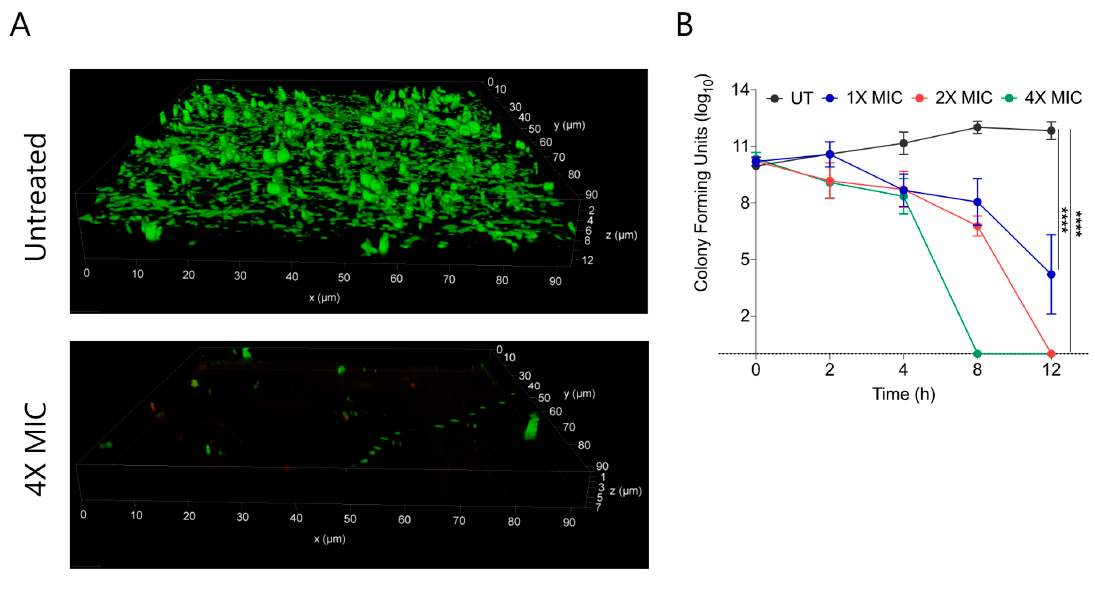
Figure 4. ( A ) Fluorescence micrographs of SYTO9/PI stained untreated and 4X MIC 99 treated (CABI- 6 ) S. aureus biofilms. ( B ) Ability of CABI- 6 potential to clear the S. aureus biofilms is confirmed by dose-dependent and time-dependent changes in CFUs. Data was analysed by ANOVA (**** p < 0.0001).